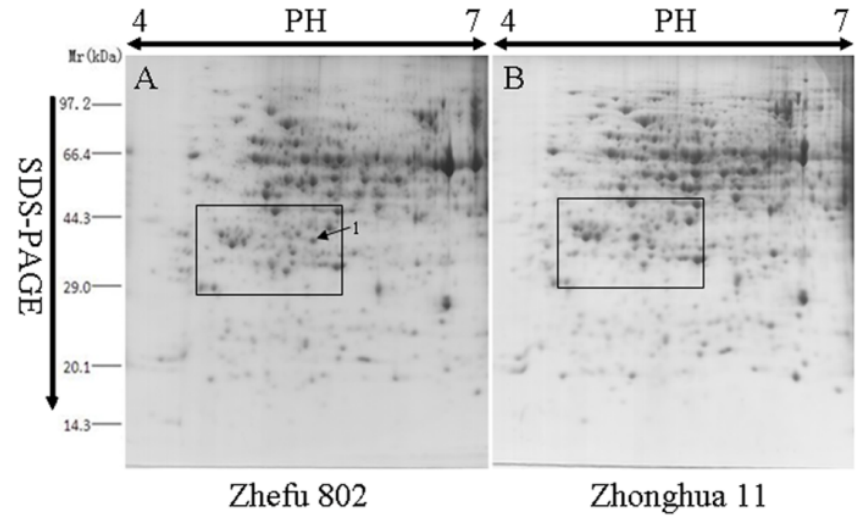
Figure 1. Comparative two-dimensional gel electrophoresis (2-DE) of proteins from Zhefu 802 ( O. sativa L. ssp. indica ) and Zhonghua 11 ( O. sativa L. ssp. japonica ) yellow seedling. Differentially expressed proteins are indicated by arrows and labeled numerically. ( A ) Zhefu 802; and ( B ) Zhonghua 11. The box in the two maps shows the interception area in Figure